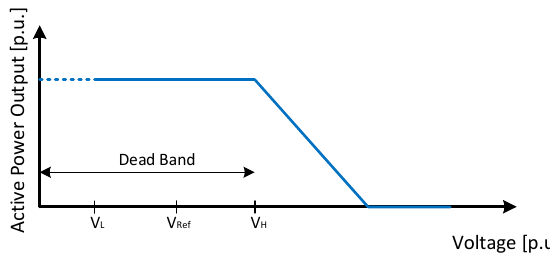
Figure 3. Generic Smart Inverter voltage-active power (Volt-Watt) Characteristic.